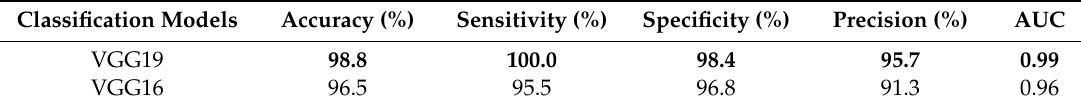
Table 8. Performance evaluation of the VGG19 and VGG16 models for predicting mild-ROP and severe-ROP. Classification